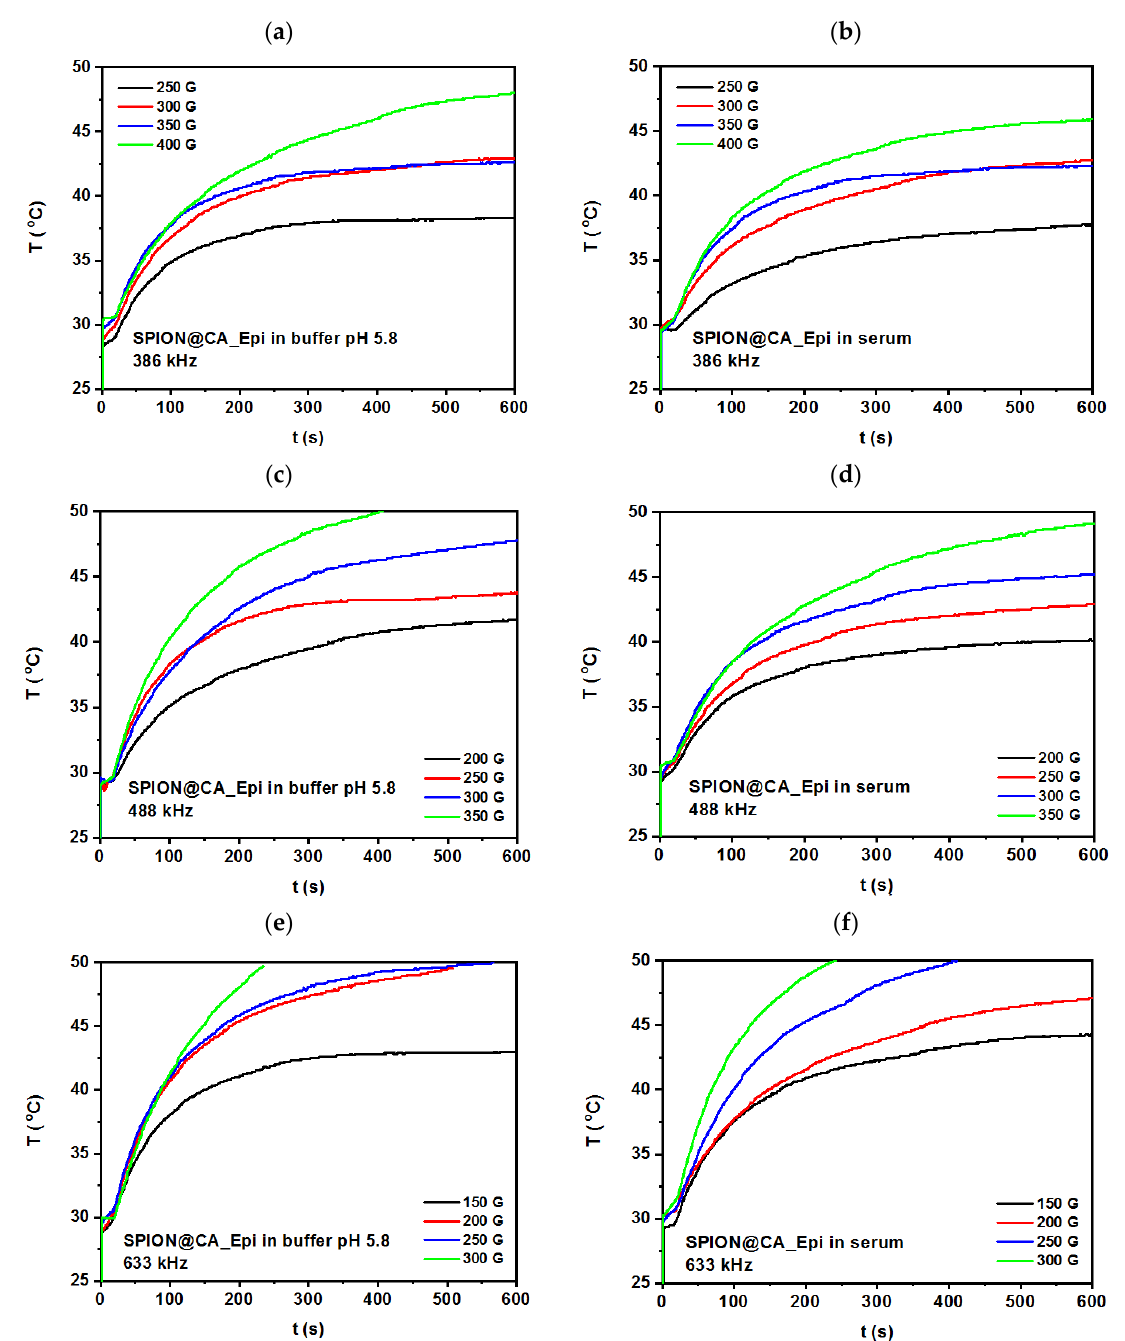
Figure 9. Temperature-time profile for hybrid SPION@CA_Epi measured at ( a , b ) at alternating magnetic field about 386 kHz, ( c , d ) 488 kHz, and ( e , f ) 633 kHz. The left column presents results for measurements performed in the phosphate buffer pH 5.8, while the right column corresponds to the experiments performed in the human serum.